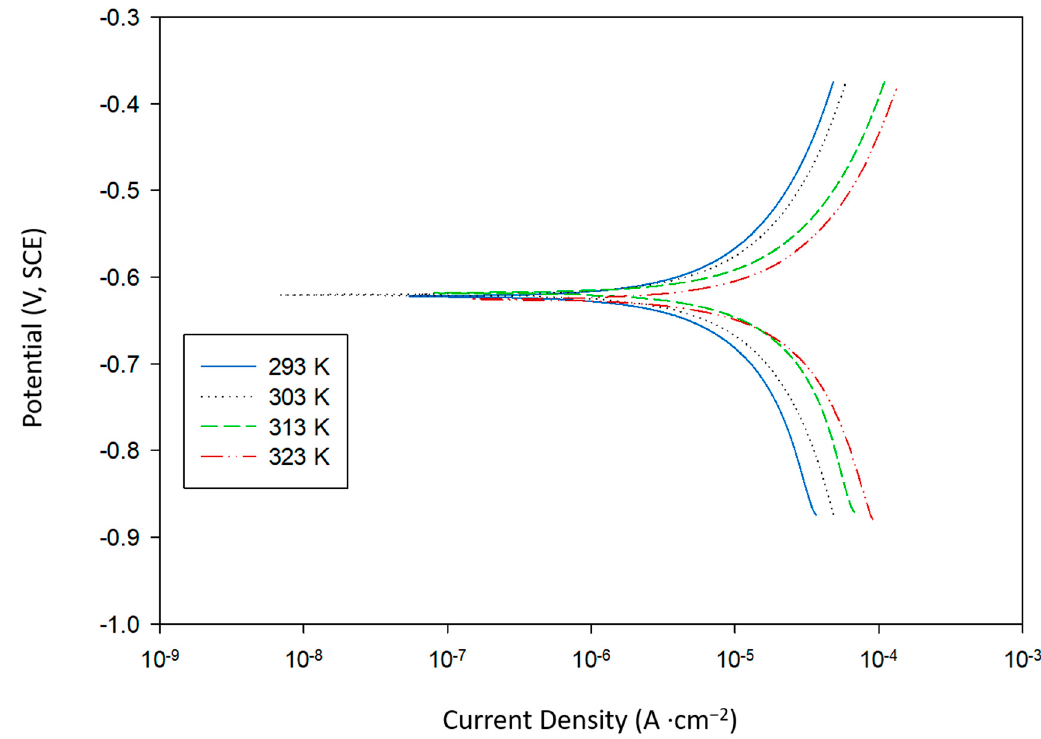
Figure 2. Potentiodynamic polarization curves for API X-120 steel alloy in GTL process water at different temperatures.